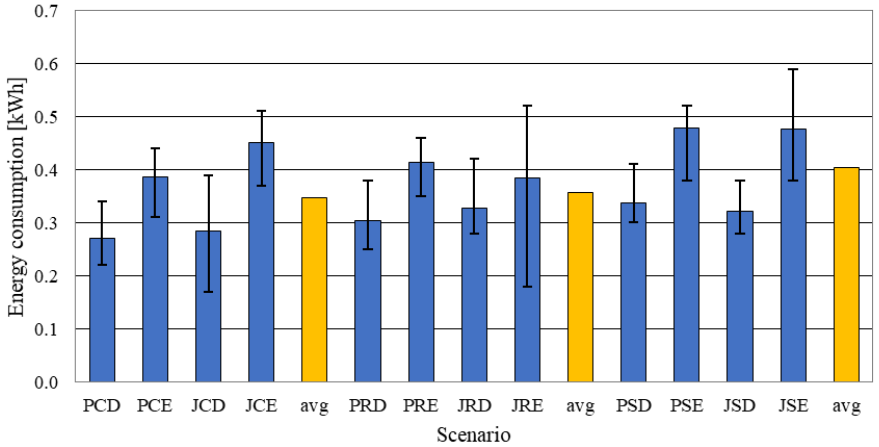
Figure 7. Energy consumption depending on simulated atmospheric conditions.